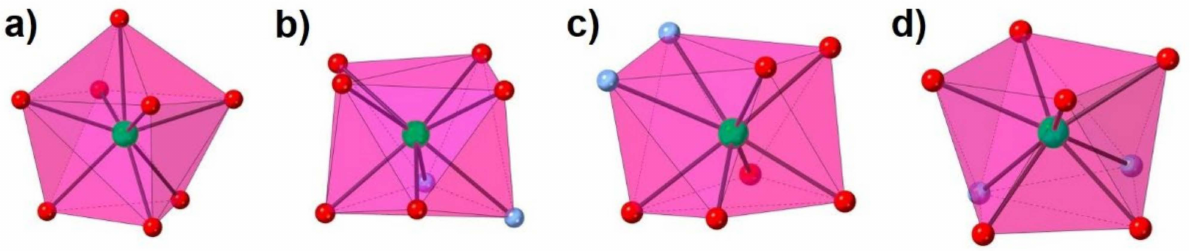
Figure 1. Partially labelled molecular plots of ( a ) [Sm(ntfa) 3 (MeOH) 2 ] (1 ), ( b ) [Sm(ntfa) 3 (bipy)] ( 2 ), ( c ) [Sm(ntfa) 3 (4,4 (cid:48) -Me 2 bipy)] ( 3 ), and ( d ) [Sm(ntfa) 3 (5,5 (cid:48) -Me 2 bipy)] ( 4 ). Color code: turquoise: Sm, red: oxygen, blue: nitrogen, black: carbon, and green: fluorine; H atoms omitted for clarity.